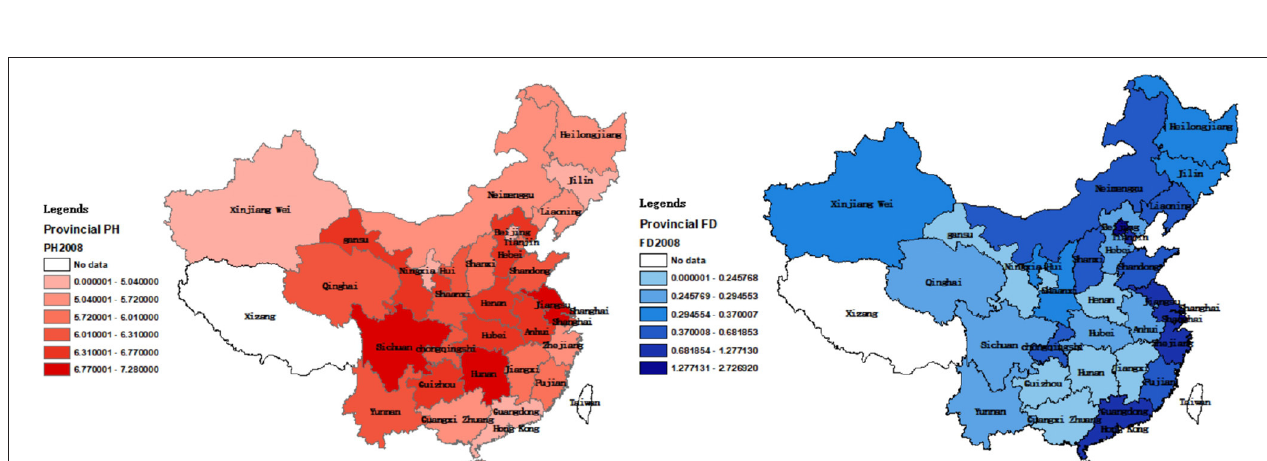
FIGURE 5 | Provincial differences in PH and FD in 2008.